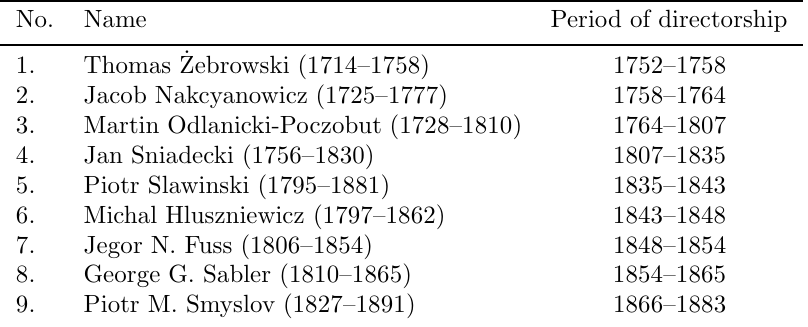
Table 1. The directors of the Vilnius